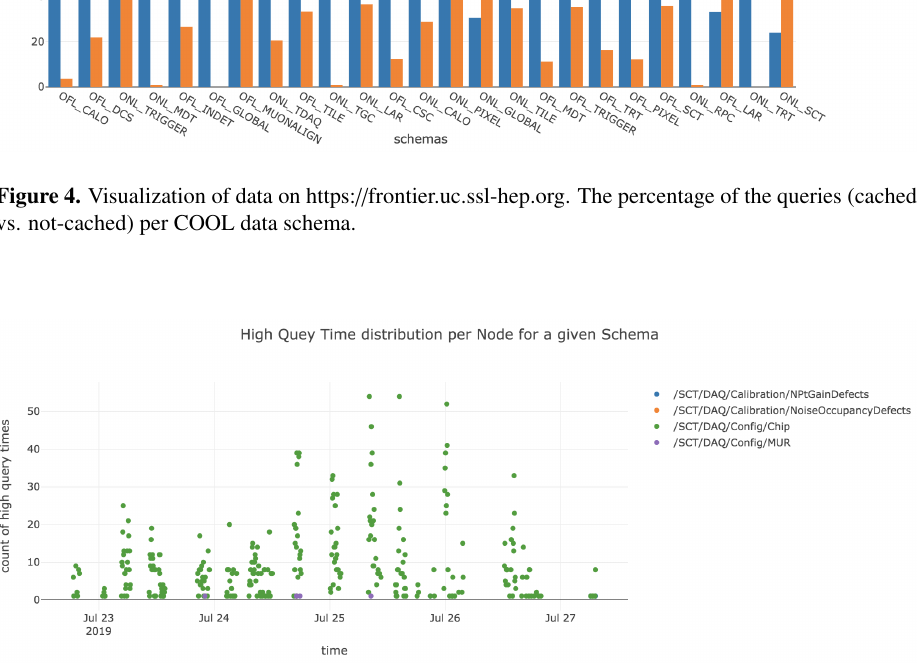
Figure 5. Visualization of data on https: // frontier.uc.ssl-hep.org. The count of queries with high pro- cessing time per node for the ONL_SCT